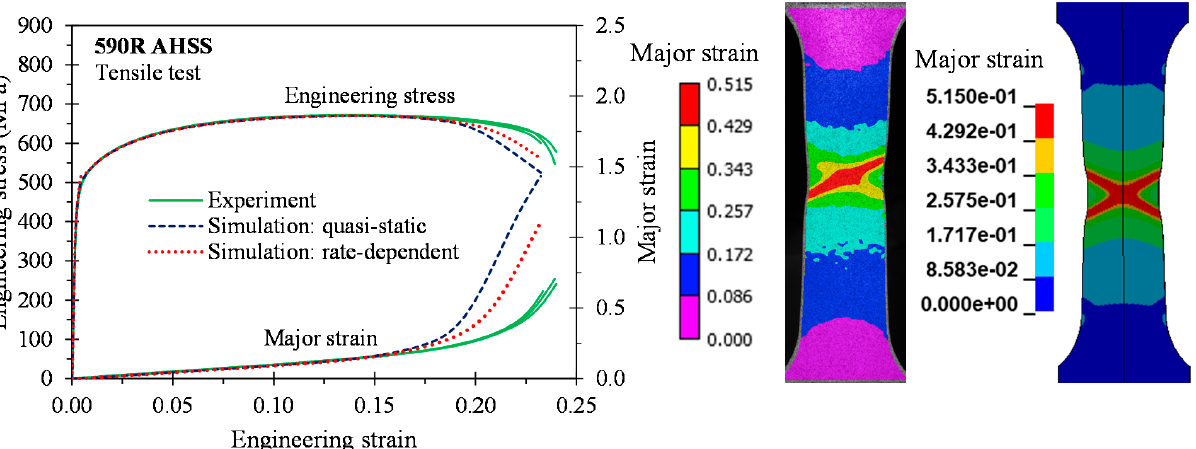
Figure 15. Comparison of the global and local response in 3D tensile simulations for the 590R.